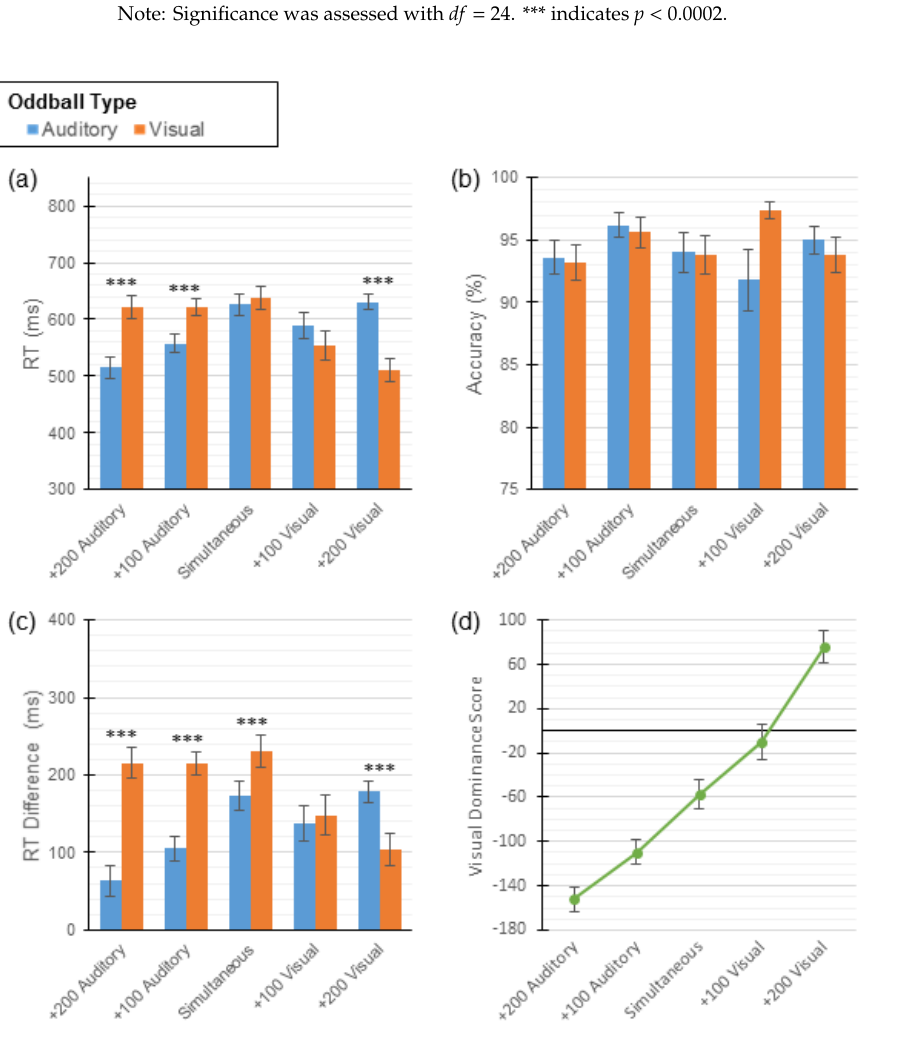
Figure 3. Mean scores for participants in Experiment 1. One-button task scores presented across all five conditions, by oddball type (auditory or visual, ( a – c ) only). Error bars show ± 1 standard error of the mean (SEM). ( a ) Mean RTs. ( b ) Mean accuracies. ( c ) Mean slowdown scores. ( d ) Mean visual dominance scores; negative values indicate auditory dominance and positive values indicate visual dominance. *** indicates p < 0.0002.